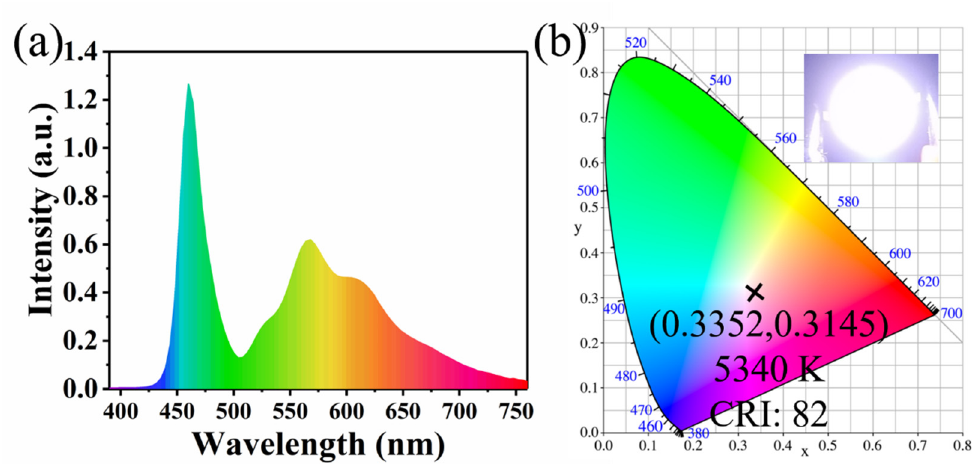
Figure 8. ( a ) Luminescence spectra and ( b ) Commission Internationale de l'Eclairage (CIE) coordinates with the photo (inset) of CQDs/PC phosphor WLED measured at 3.0 V voltage.